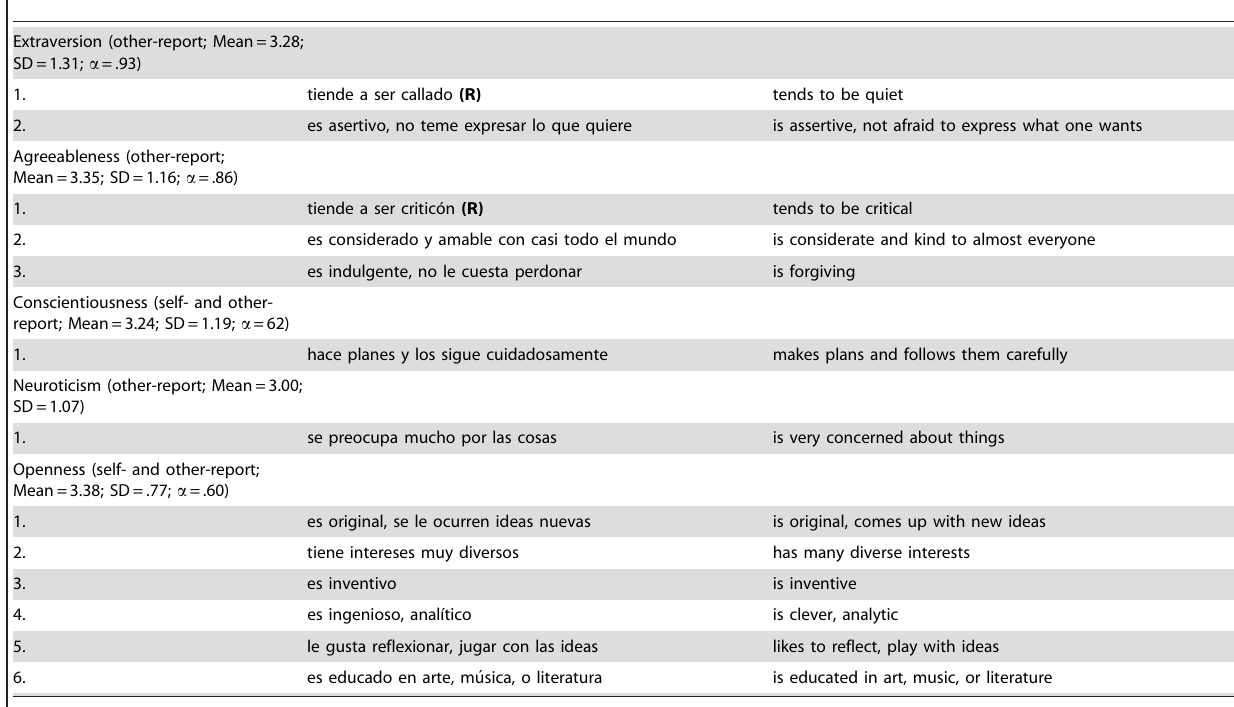
Table 2. Items Used to Calculate Factor Scores, with English